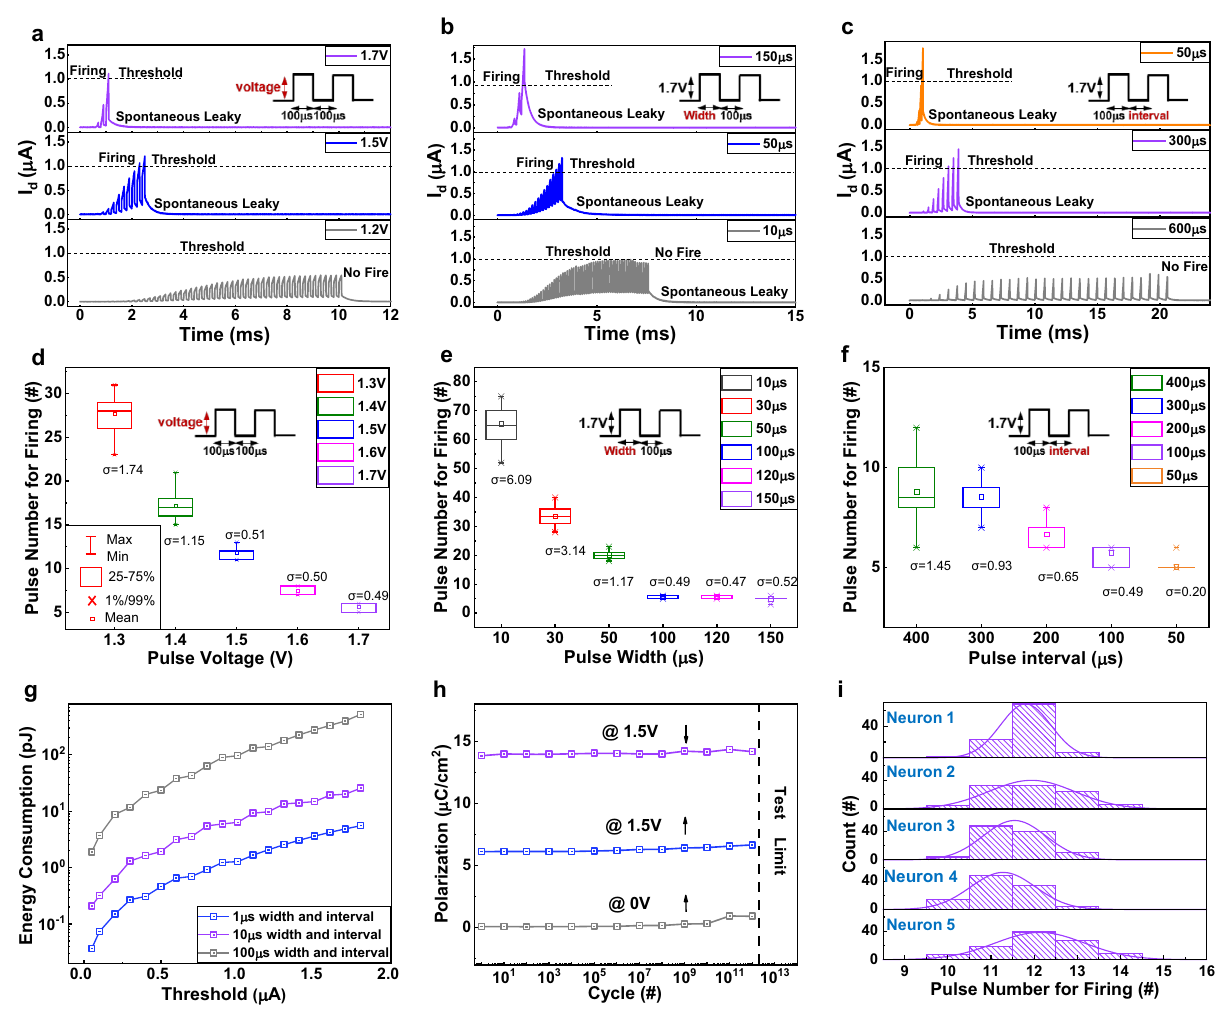
Fig. 3 | AFeFET LIF neuron device characteristics. The dynamic of the strength- modulated integration process of AFeFET neuron under ( a ) different gate pulse amplitudes (1.2 – 1.7V amplitude, fi xed 100 μ s interval, fi xed 100 μ s width), b different gate pulse widths ( fi xed 1.7V amplitude, fi xed 100 μ s interval, 10 μ s – 150 μ s width), c different gate pulse intervals ( fi xed 1.7V amplitude, 50 – 600 μ s interval, fi xed 100 μ s width). When the input pulse intensity is not enough, the AFeFET neuron cannot fi re. Statistical data of input pulse numbers of AFeFET neuron fi ring asa function of d amplitudes, e widths, f intervals. The fi ring event needs fewer input spikes and tends to bemore stable asthe stimuli intensity increasing. Each data point is collected from 50 fi ring activities. g The energy